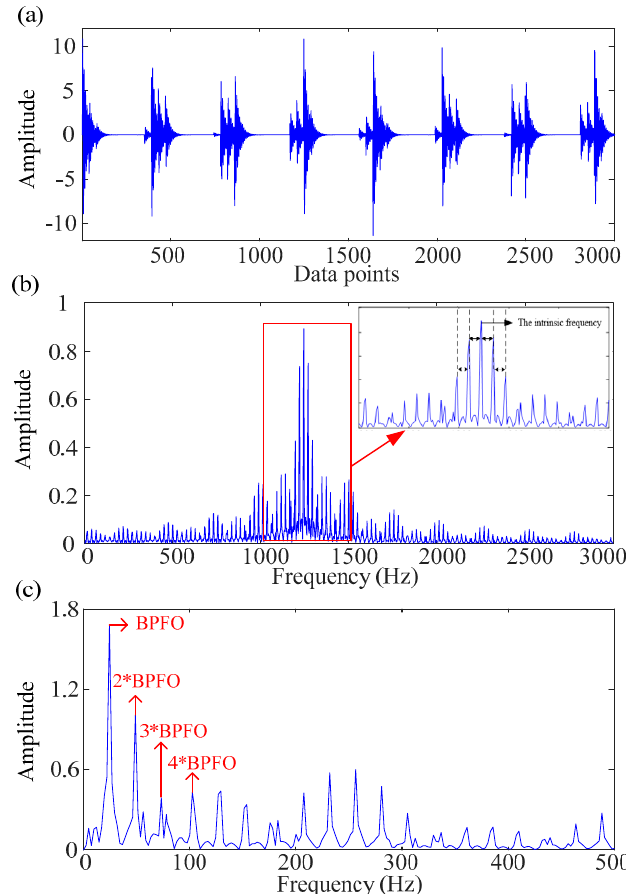
Figure 8. The simulated bearing signal with outer race fault: ( a ) the waveform, ( b ) its corresponding fast Fourier transform (FFT) spectrum, ( c ) the envelope